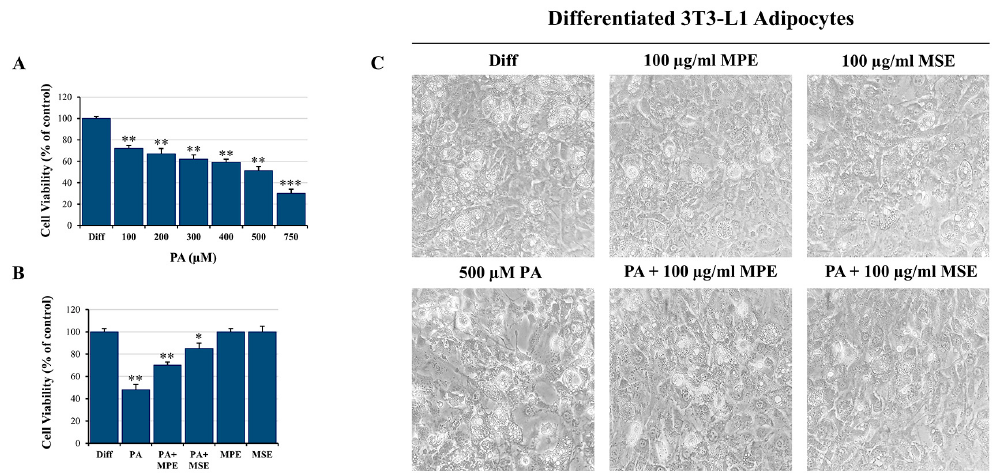
Figure 2. MPE and MSE counteract PA-induced toxicity in 3T3-L1 adipocytes. Di ff erentiated 3T3-L1 adipocytes were exposed for 48 h to different doses of PA alone or in the presence of 100 µ g/mL MPE and MSE. ( A ) MTT assays showing the reduction of cell viability induced in differentiated 3T3-L1 adipocytes by different doses of PA. ( B ) MTT assays showing the ability of 100 µ g/mL of MPE or MSE to counteract the cytotoxic effect of 500 µ M PA in differentiated 3T3-L1 adipocytes. ( C ) Representative phase contrast microscopy images showing the morphological changes induced by 500 µ M PA alone or in the presence of 100 µ g/mL MPE or MSE in differentiated 3T3-L1 adipocytes. ( A , B ) The values reported are the mean ± SD of three independent experiments. The statistical differences between groups were evaluated using a one-way ANOVA test. * p < 0.05, ** p < 0.01 and *** p < 0.001 were significant with respect to differentiated 3T3-L1 adipocytes treated with only vehicle BSA.